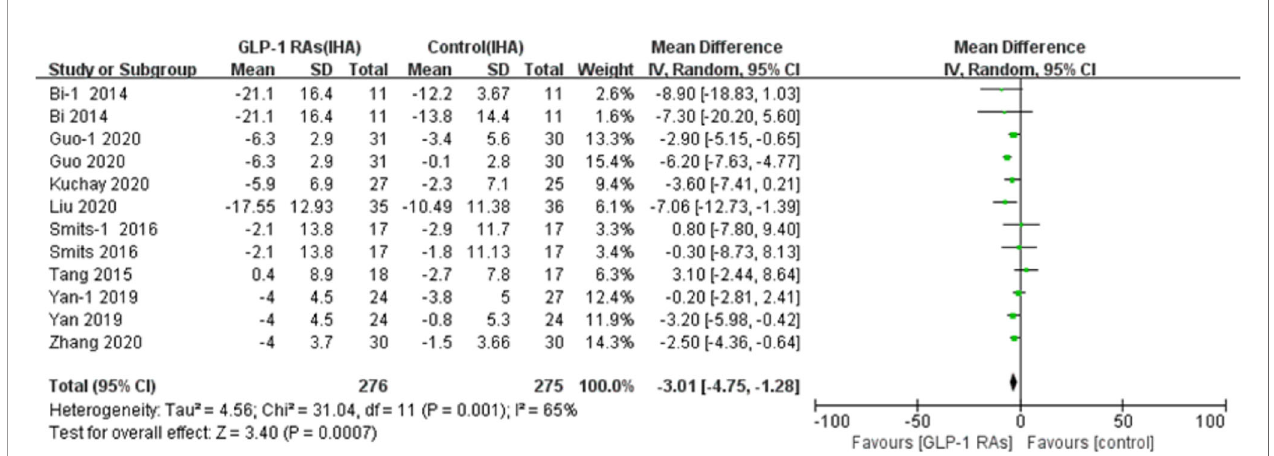
FIGURE 4 | Glucagon-like peptide-1 receptor agonists (GLP-IRAS); intrahepatic adipose (IHA); SD, standard deviation; CI, con fi dence interval; IV, inverse variance; Bi-l, concluded exenatide vs pioglitazone; Guo-l, concluded liraglutide vs insulin; Smits-l, concluded liraglutide vs placebo; Yan-1, concluded liraglutide vs